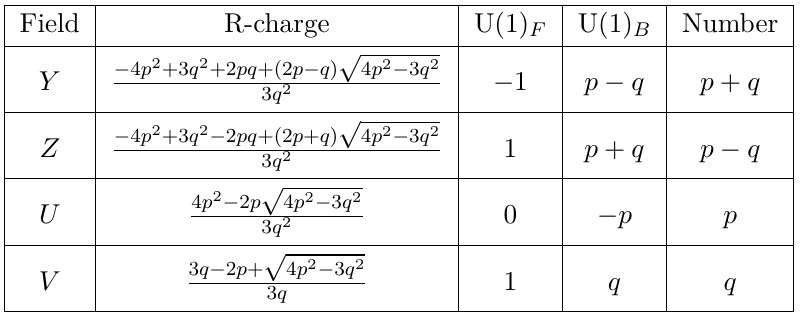
Table 2 . Fields and charges in the Y p,q